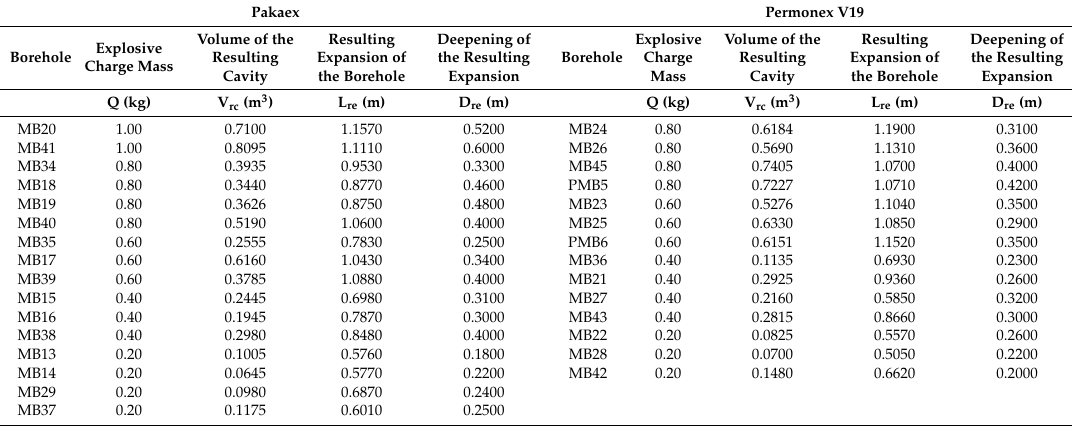
Table 1. The results of spherical cavity blasting for explosives Pakaex and Permonex V19. Pakaex Permonex V19